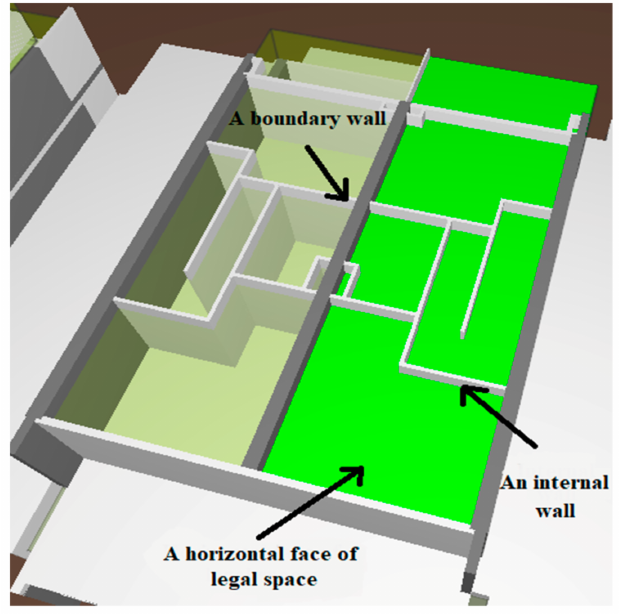
Figure 14. A horizontal face of legal space has intersections with both internal and boundary